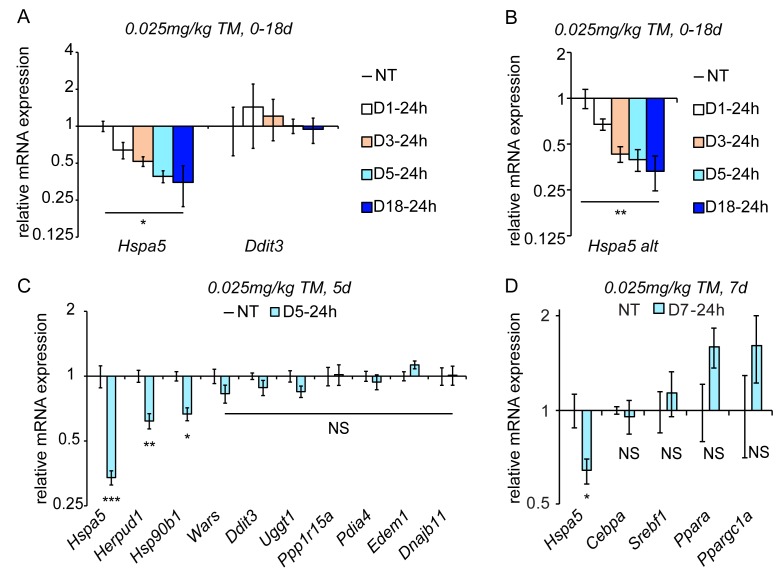
Chronic stress suppresses a subset of UPR target genes.(A) Mice were injected with 0.025 mg/kg TM daily for up to 18 days, and livers were collected 24 hr after the last injection as indicated. Expression of Hspa5 and Ddit3 was measured by qRT-PCR. Expression is given relative to vehicle-treated control mice. Data for all qRT-PCR experiments is shown on a log scale. n = 2–3 animals/group (B) Expression of Hspa5 using an alternate primer pair spanning a different exon/intron junction confirms results from (A). (C) qRT-PCR of a group of UPR target genes from animals treated with vehicle or TM for 5d. n = 8 animals/group from two experiments. (D) Expression of the indicated metabolic genes was determined by qRT-PCR from an experiment similar to (C), except injections were performed for 7d. n = 4 animals/group.DOI:
http://dx.doi.org/10.7554/eLife.20390.00510.7554/eLife.20390.006Figure 2—source data 1.Contains raw and transformed Ct values for qRT-PCR experiments in Figure 2A–D.